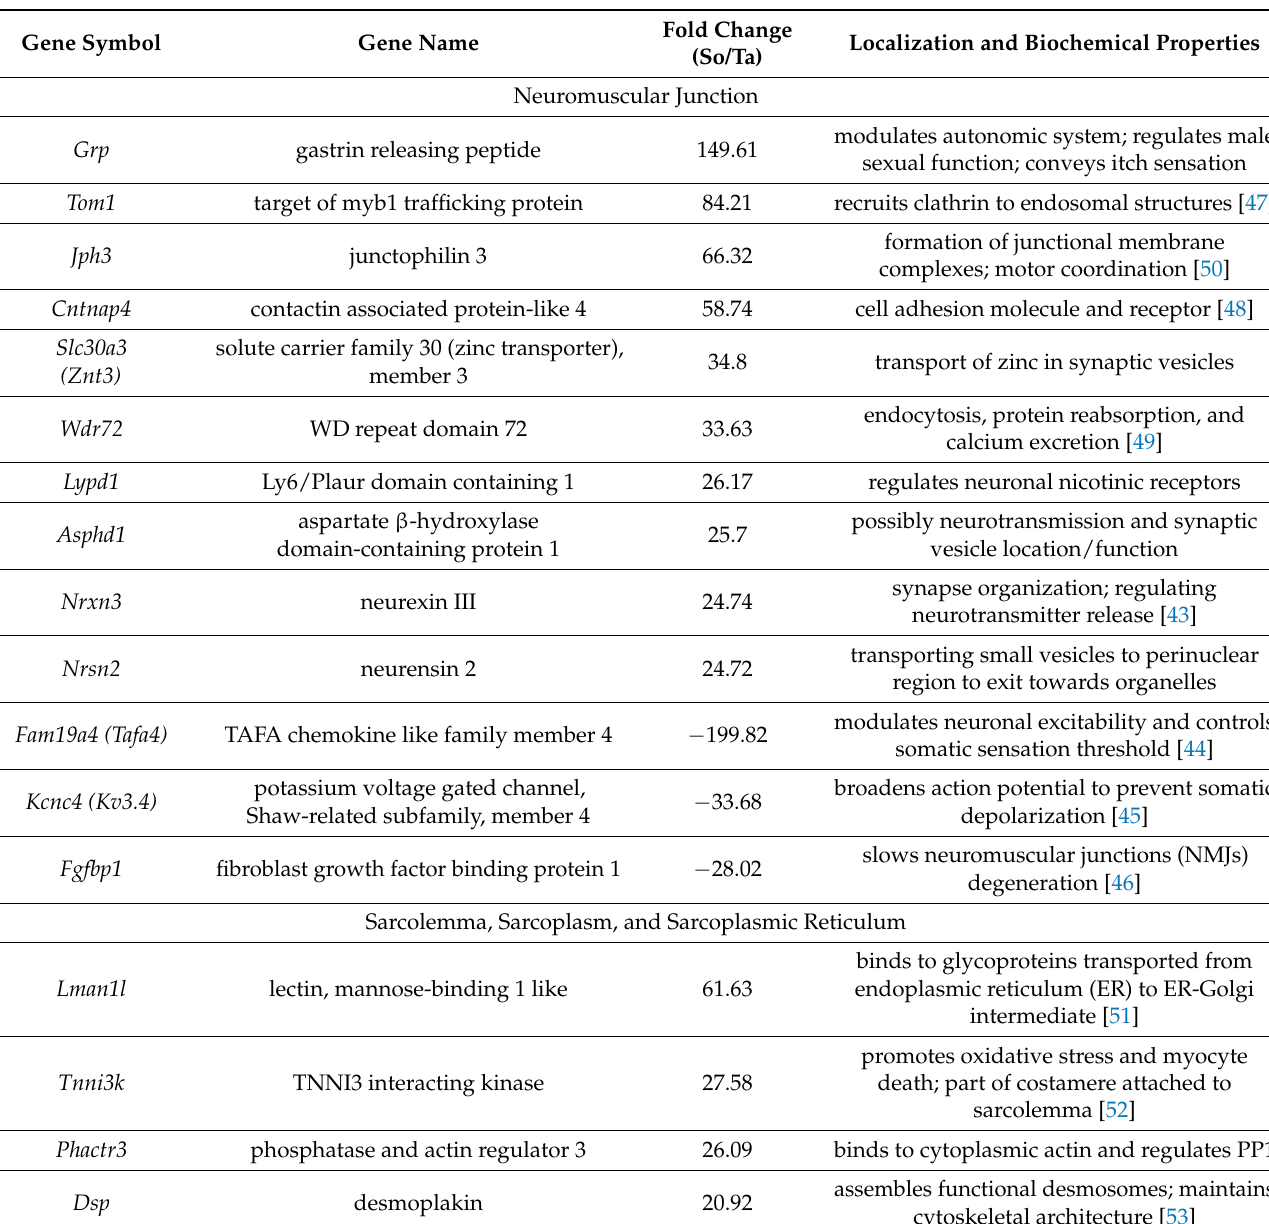
Table 3. Differentially expressed genes associated with contractile related